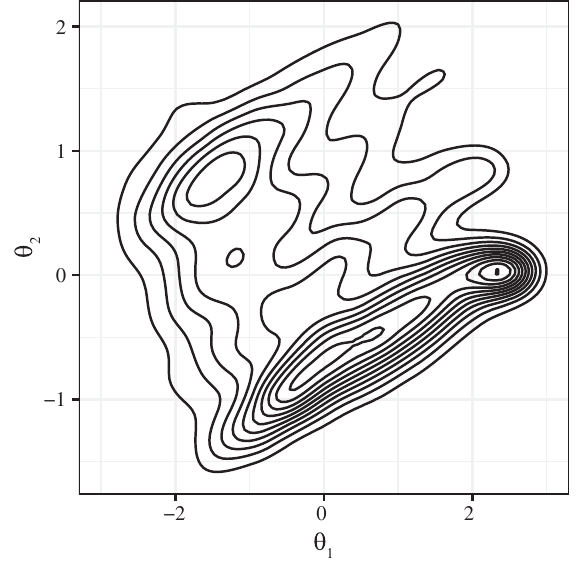
FIG. 2. Density contours plotting θ 2 vs θ 1 for sample 1.